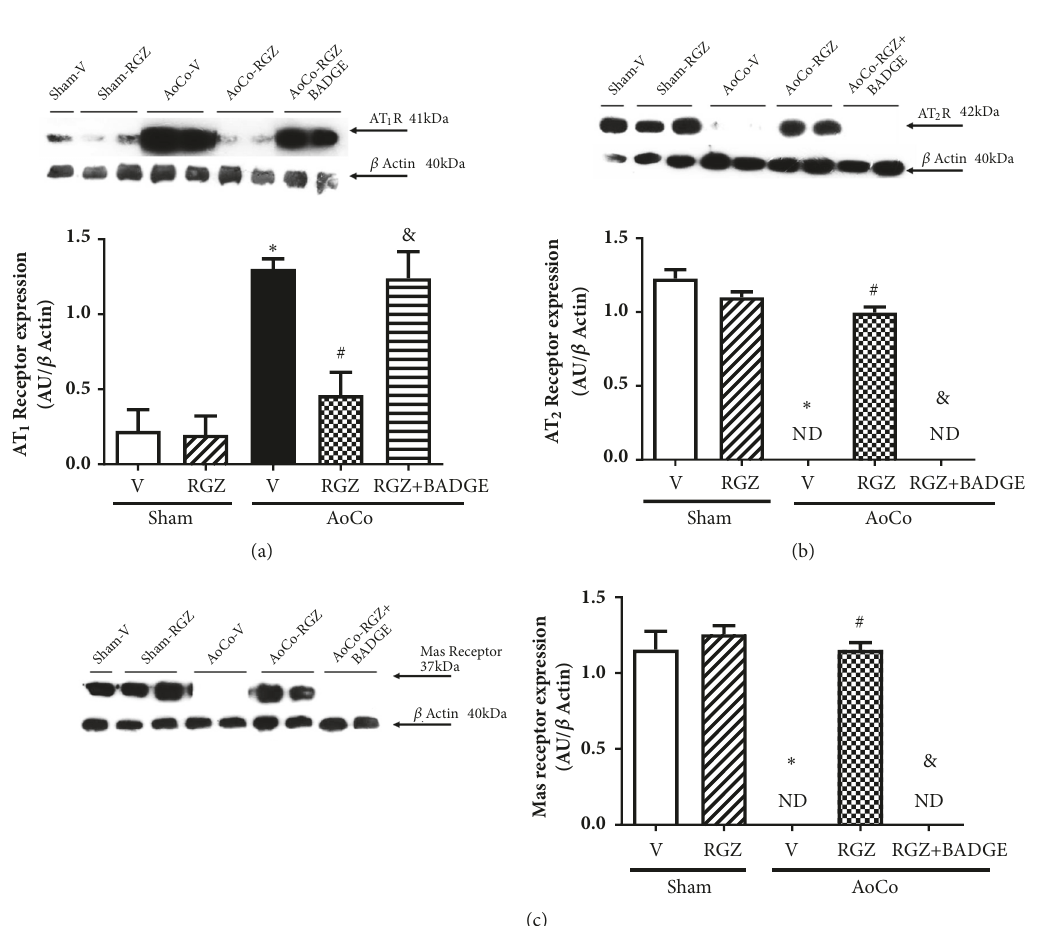
Figure 4: Effect of rosiglitazone (RGZ) on aortic angiotensin II type 1 (AT 1 R) (a), angiotensin II type 2 (AT 2 R) (b), and Mas (c) receptor expression. The images show representative western blots. The protein expression was evaluated in homogenate of aorta from sham or aortic coarctated (AoCo) rats treated with vehicle (V), rosiglitazone (5mg/kg, RGZ), or RGZ + bisphenol A diglycidyl ether (120 mg/kg, RGZ+BADGE). The values represent the mean ± SEM (n=6 animals per group). One-way analysis of variance (ANOVA) post Tukey. ∗ P < 0.05 Sham-V vs. AoCo-V, # P < 0.05 AoCo-V vs. AoCo-RGZ, and & P < 0.05 AoCo-RGZ vs. AoCo-RGZ+BADGE. ND: not